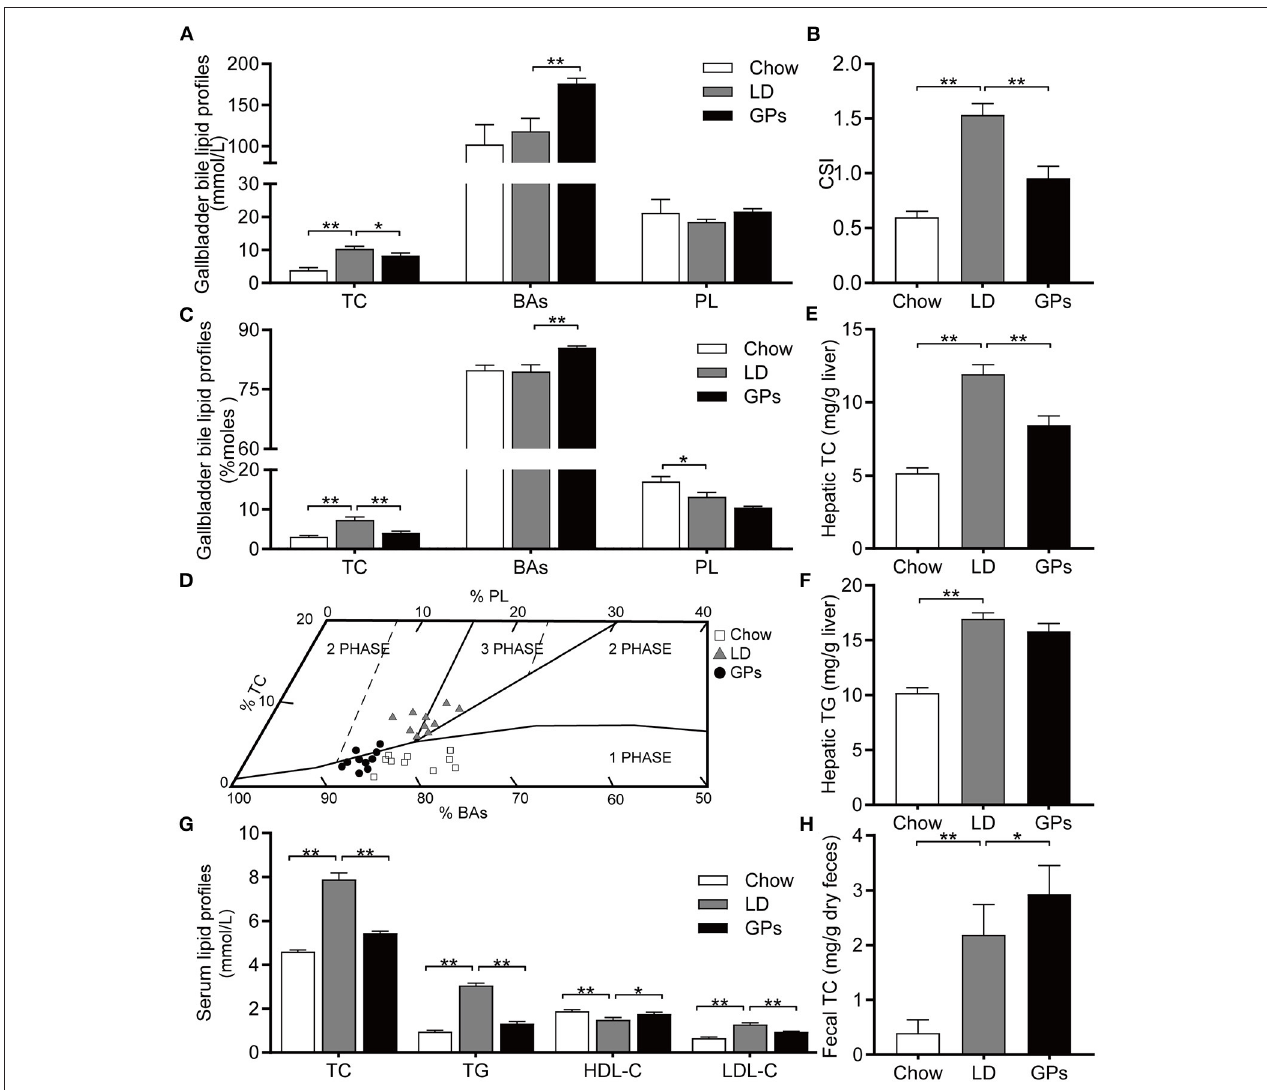
FIGURE 2 | Effect of Gypenosides (GPs) on the lipid composition of gallbladder bile, and on lipid profiles in liver and serum. (A) Concentrations of total cholesterol (TC), bile acids (BAs) and phospholipids (PL). (B) Cholesterol Saturation Index (CSI). (C) Molar percentages of TC, BAs and PL. (D) Mean relative lipid composition (moles per 100 moles) of pooled gallbladder bile samples plotted on a condensed phase diagram. Depicted are the one-phase zone (only micelles); the left two-phase zone (containing micelles and crystals); the right two-phase zone (containing micelles and vesicles) and the three-phase zone (containing micelles, vesicles and crystals). (E,F) Hepatic concentrations of (E) TC and (F) triglycerides (TG). (G) Serum concentrations of TC, TG, low-density lipoprotein-cholesterol (LDL-C) and high-density lipoprotein-cholesterol (HDL-C). (H) Fecal concentration of TC. Data are reported as means ± SEM ( n = 10). * P < 0.05, ** P <